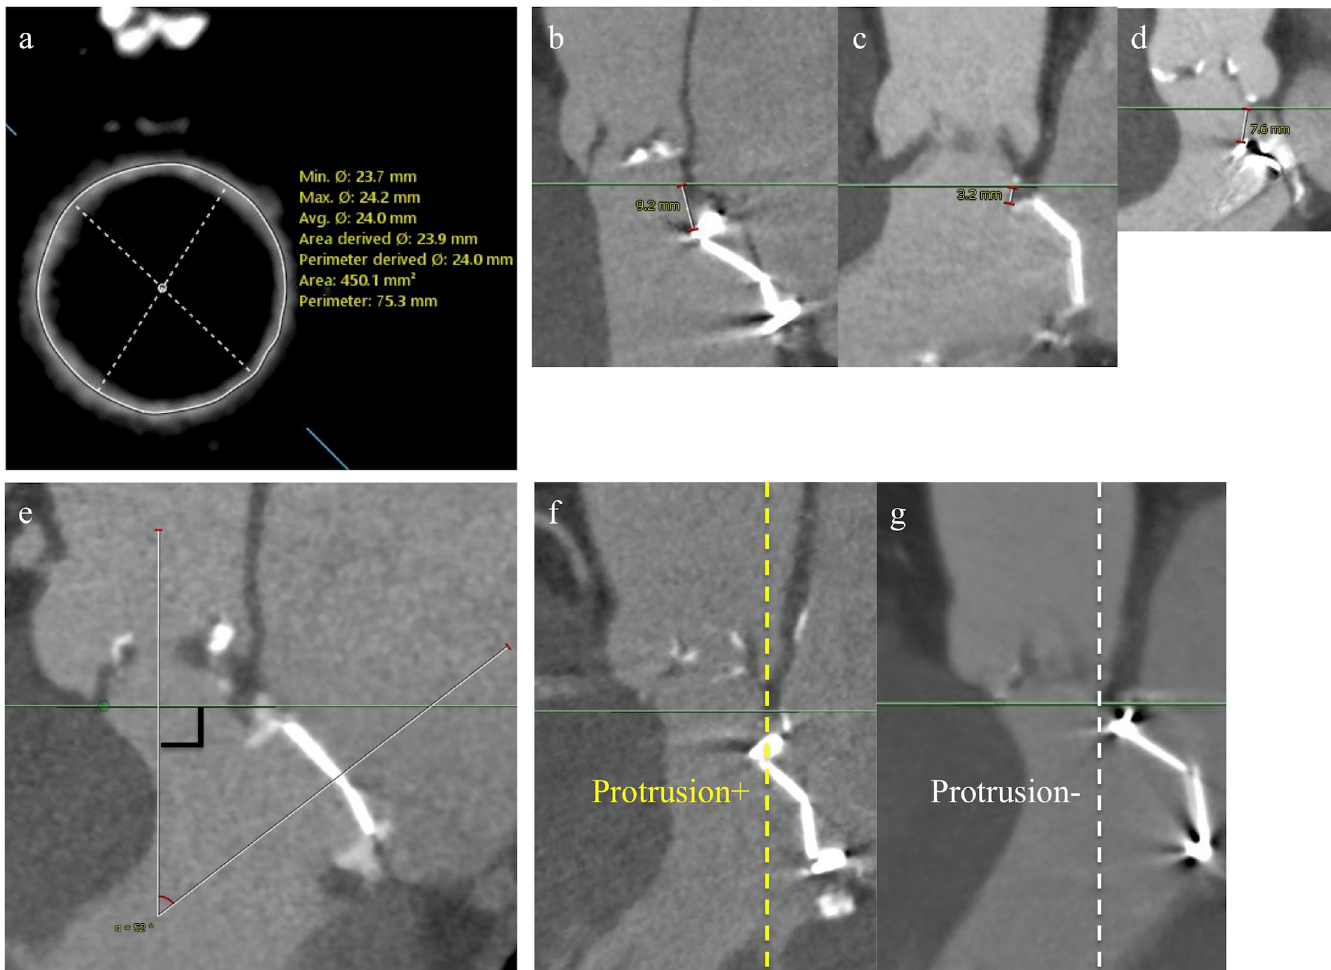
Fig 1. Preprocedural MDCT measurement. (a) Size of the mitral prosthesis housing. (b and c) The distance between the aortic annulus and mitral prosthesis housing. (d) The distance between the aortic annulus and the stem of the mitral bioprosthesis. (e) The angle between the mitral prosthesis and LVOT. (f and g) Assessment of mitral prosthesis protrusion to the LVOT. LVOT = left ventricular outflow tract; MDCT = multidetector computed tomography.